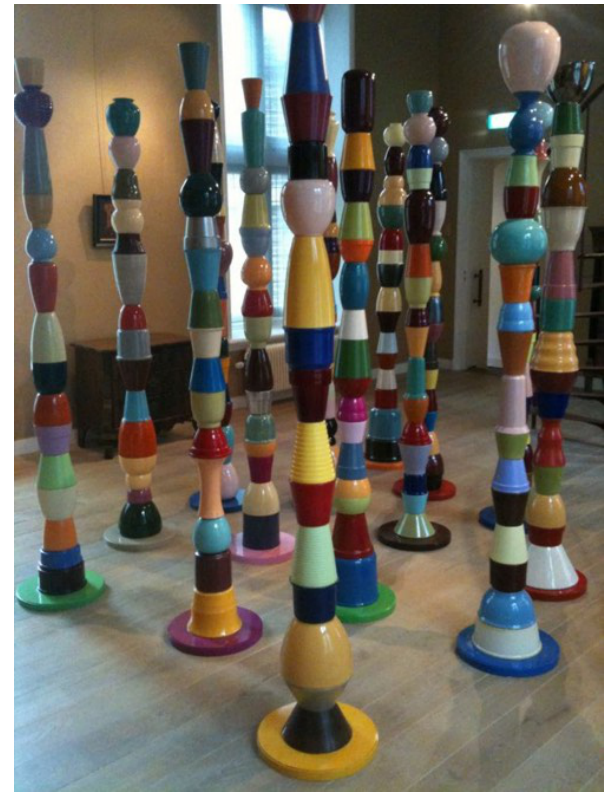
Figure 4: Rob Scholte: Pots.